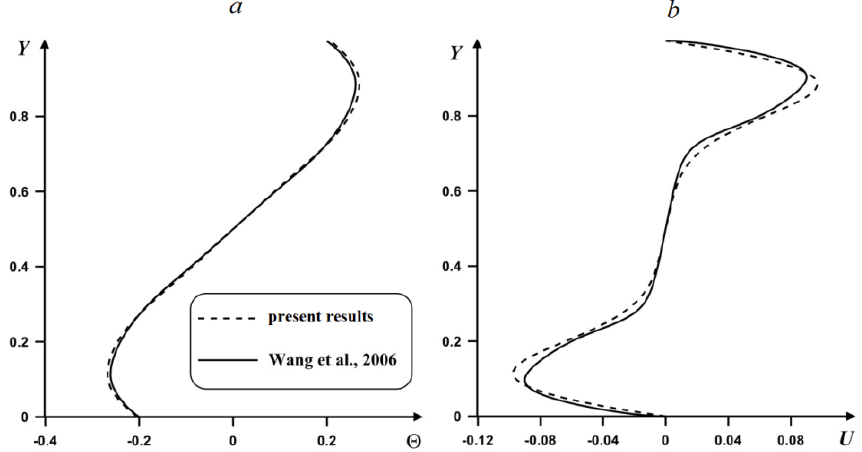
Figure 3. Profiles of ( a ) temperature and ( b ) horizontal velocity at X = 0.5 at Ra = 10 6 , (cid:101) (cid:101) = 0.2 in comparison with numerical data of Wang et al. [27].